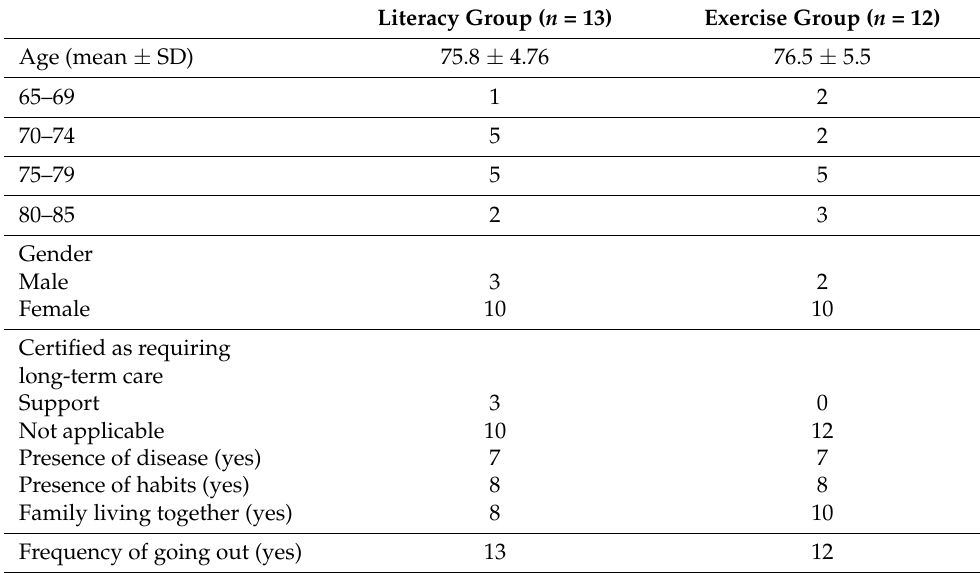
Table 2. Attributes of the final analysis subjects in both groups.